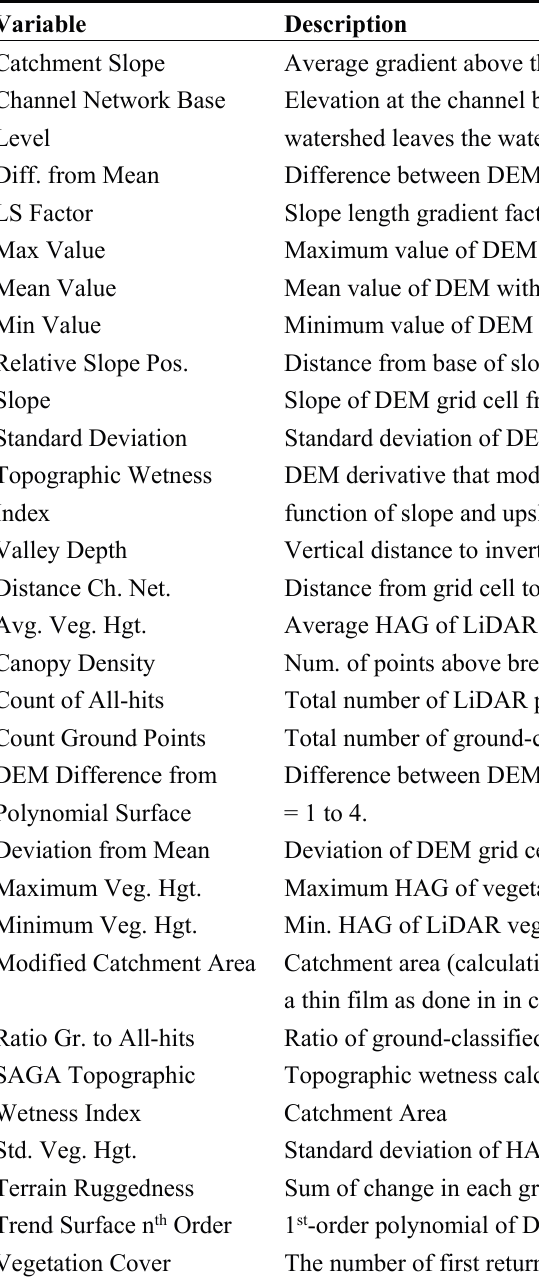
Table 1. List of Digital Elevation Model (DEM), Digital Surface Model (DSM) and point cloud derivatives used in classification created in SAGA [32]. Raster/point describes if the derivative was calculated from raw LiDAR points or a raster surface [35]. Abbreviations: HAG = height above ground; veg = vegetation; hgt = height; avg= average; and std= standard